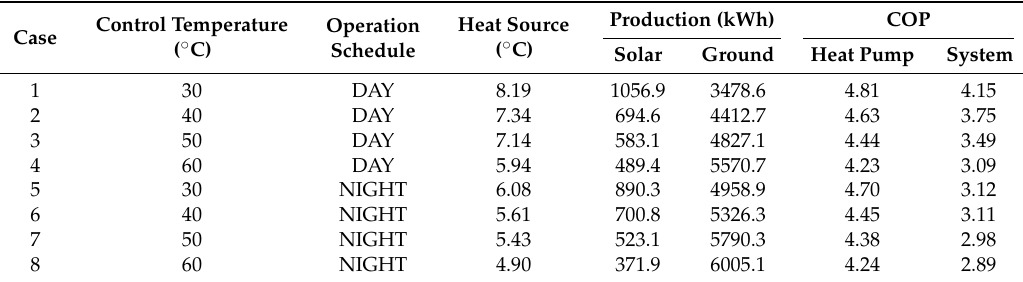
Table 4. Simulation results according to the control temperature in SYSTEM